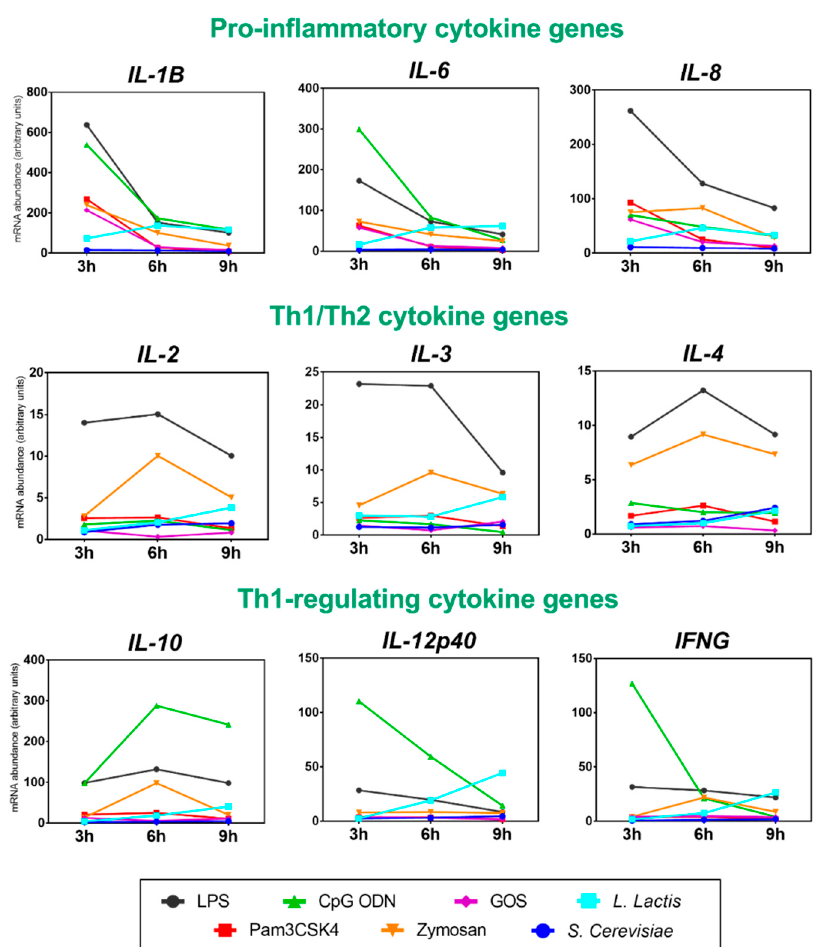
Figure 2. Cytokine gene expression analysis generated from chicken peripheral blood mononuclear cells (PBMC) stimulated with TLR agonists. The PBMC stimulation experiment was performed as follows: 1.25 × 10 7 cells/well were stimulated with: LPS, CpG ODN, Pam3CSK4, Zymosan, GOS, Lactococcus lactis subsp. cremoris , and Saccharomyces cerevisiae . The stimulation experiment was conducted in a time-course manner and lasted: 3 h, 6 h, and 9 h. Cells were harvested after each time-point for RNA isolation and subsequent RT-qPCR analysis. The cytokine gene panel included: IL-1 , IL-2 , IL-3 , IL-4 , IL-6 , IL-8 , IL-10 , IL-12p40 , and IFN- ɣ genes . Gene expression analysis performed using RT-qPCR with ACTB and G6PDH reference genes.